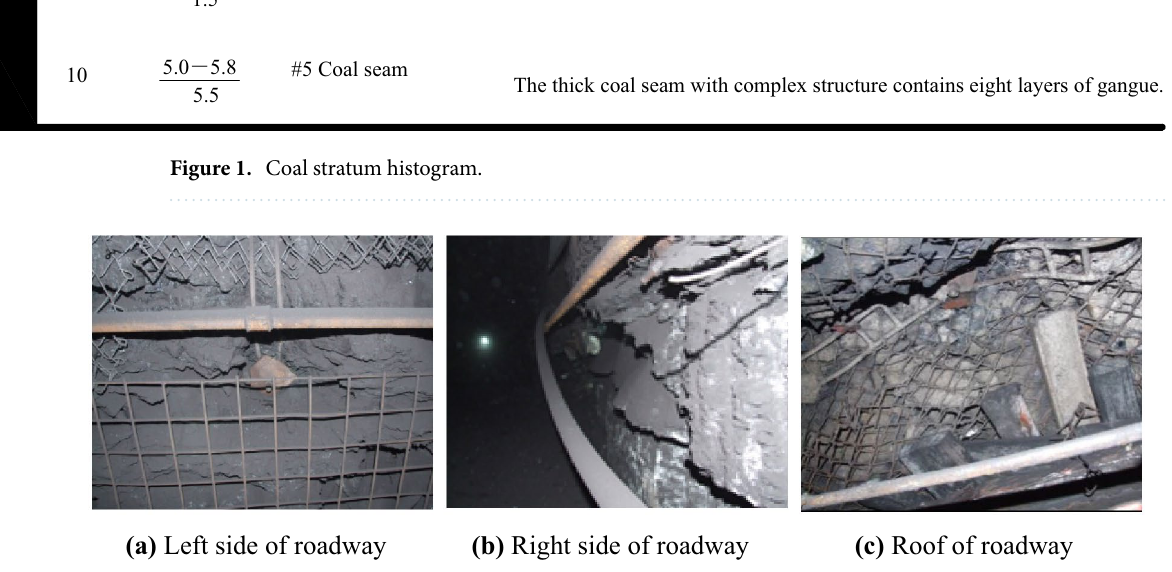
Figure 2. Deformation and failure of on-site